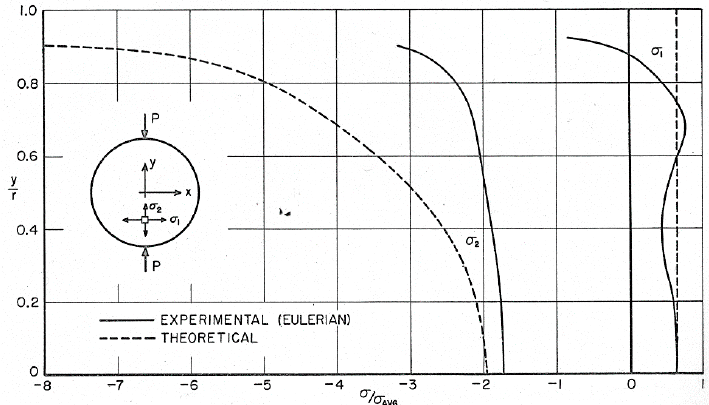
Figure 19. Comparison of experimental and theoretical distributions of principal stresses along the disk vertical axis of symmetry.